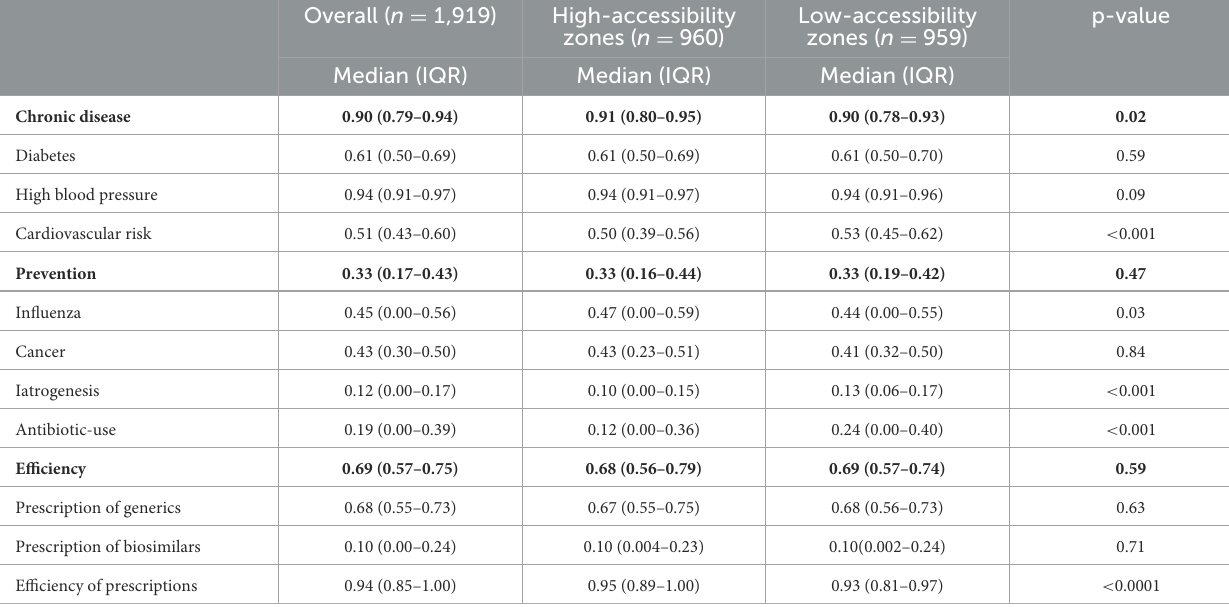
TABLE 4 Comparison of ROSP scores in the Aube department between zones with high ( > median) vs. low ( < median) local potential accessibility (LPA) score from 2017 to